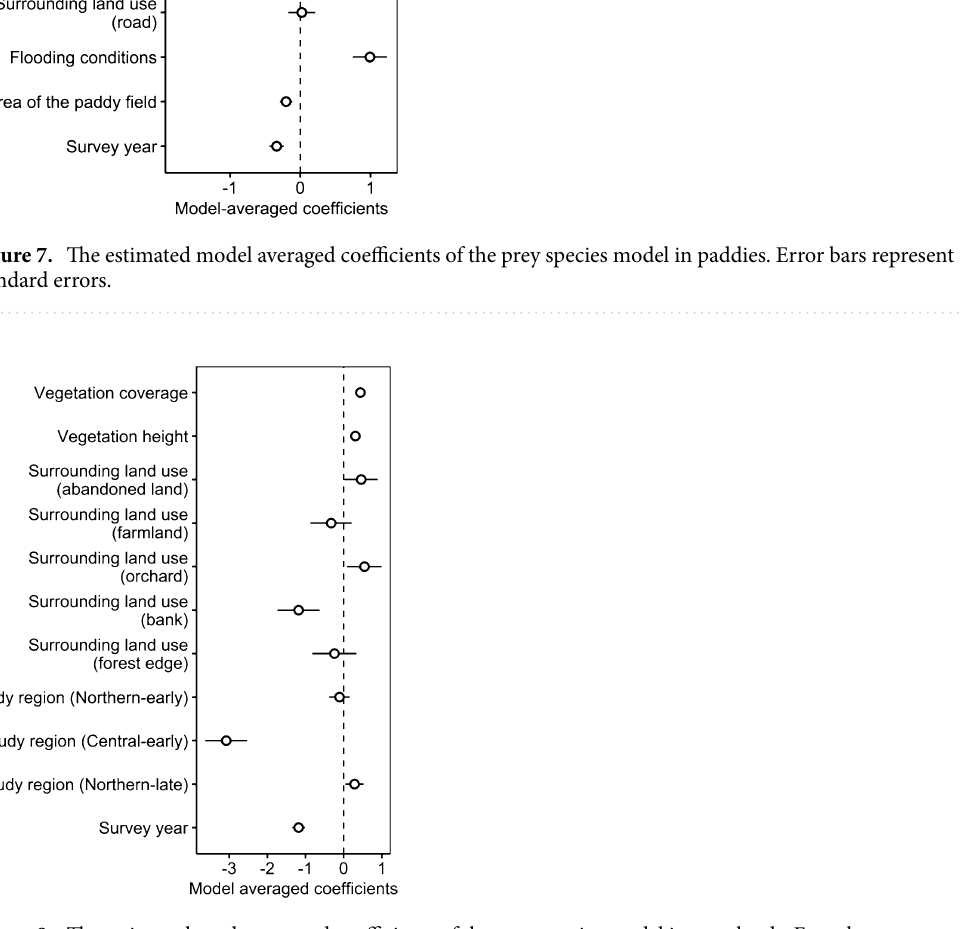
Figure 8. The estimated mode averaged coefficients of the prey species model in grasslands. Error bars represent standard